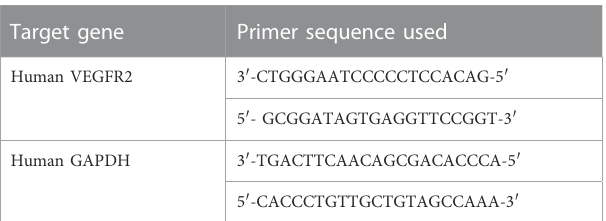
TABLE 1 Gene primer sequences used for qRT-PCR analysis. Target gene